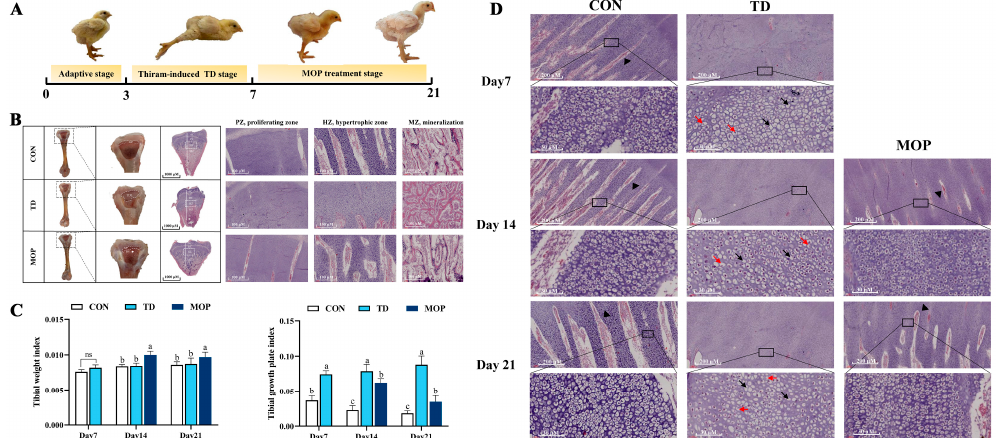
Figure 2. ( A ) Clinical characteristics of broiler chickens in adaptation stage, thiram-induced TD stage and MOP treatment stage. ( B ) Morphological alteration of tibia and tibial growth plate, HE staining of the tibial growth plate. BV, blood vessel; GP, growth plate; TDL, tibial dyschondroplasia lesion. AC, articular cartilage; HZ, hypertrophic zone; PZ, proliferation zone. MZ, mineralization zone. ( C ) Tibial growth plate index and tibial weight index. Bars with no common small letters (a, b, c) indicate statistical differences among the three treatments ( p < 0.05). ns showed no statistical significance among the three treatment groups ( p > 0.05). ( D ) The histopathological examination of vascular distribution and cell morphology in hypertrophic zone of tibial growth plate on various days 7, 14, and 21. Black arrow, nuclear lysis; Red arrow, nuclear fragmentation; Black triangle, blood vessel.